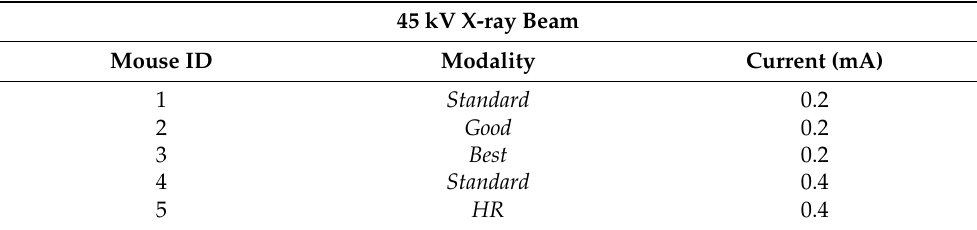
Figure 3. The TLD-100 dosimeters’ locations under the rodent’s skin. The image corresponds to the three-dimensional reconstruction of one of the mice imaged in the microCT unit at 45 kV, 0.2 mA, in the Best modality. Table 1. MicroCT image settings used for the experimental IDS measurements in mice.